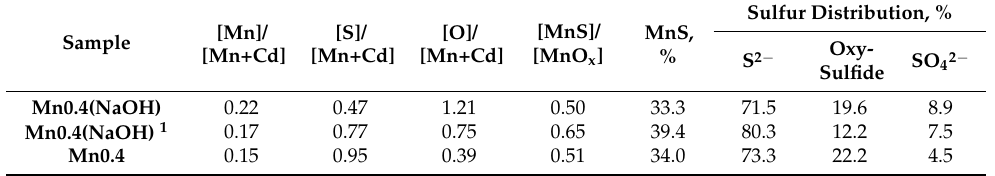
Table 2. Surface concentration of elements and compounds calculated from XPS